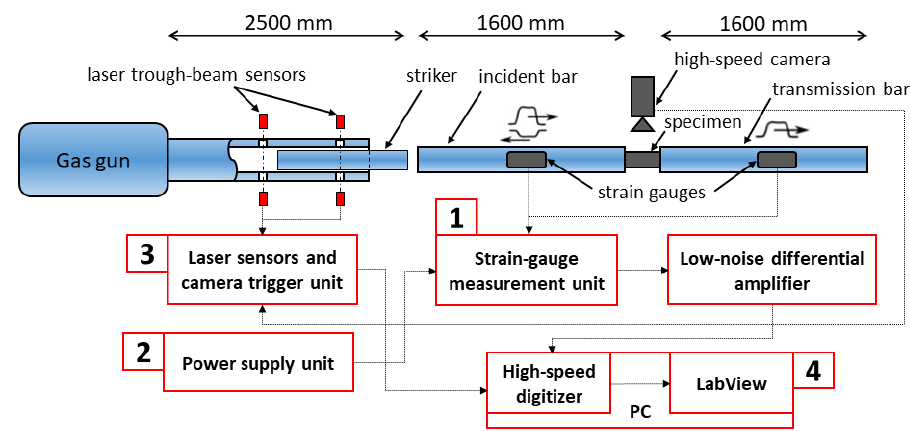
Figure 1. SHPB assembly instrumentation scheme.